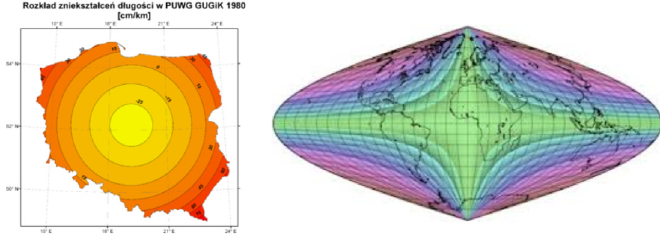
Fig. 7. The presentation of the distribution of distortions using the isolines and scale of colours (source: https://pl.wikipedia.org/wiki/Uk%C5%82ad_GUGIK_1980#/media/File:Gugik80_znieksztalcenia.png and http://www.progonos.com/furuti/MapProj/Dither/CartProp/DefPatA/defPatA.html)